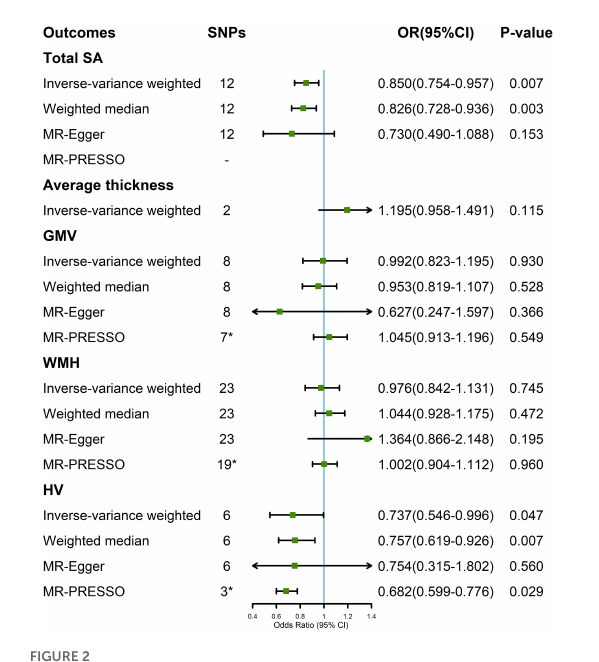
FIGURE2 Association between genetically determined brain structural alterations and migraine risks. *MR-PRESSO outlier detected ( Supplementary Table 2 ). CI, confidence interval; OR, odds ratio; SNP, single nucleotide polymorphism; WMH, white matter hyperintensities.